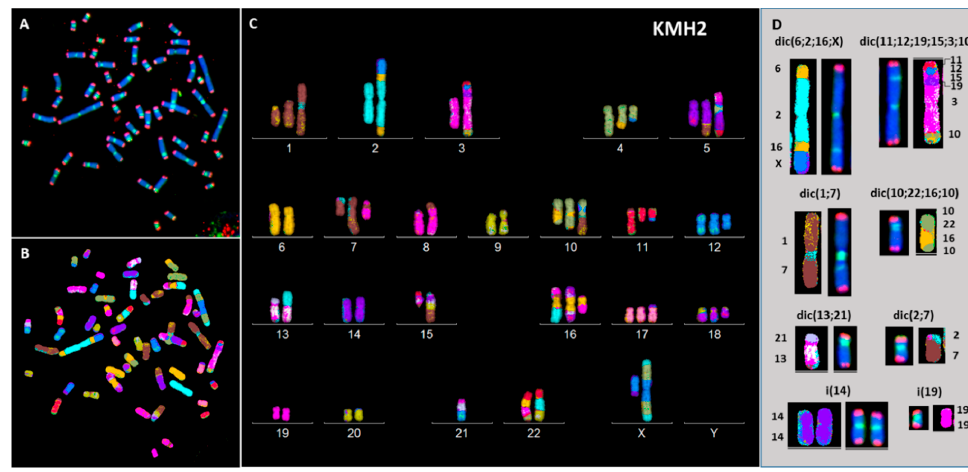
Figure 6. Breakpoints in clonal dicentric chromosomes in KMH2 cells. ( A ) telomere and centromere staining followed by ( B ) M-FISH and ( C ) chromosome classification revealed ( D ) pericentromeric breakpoints in dicentric chromosomes (63× magnification).